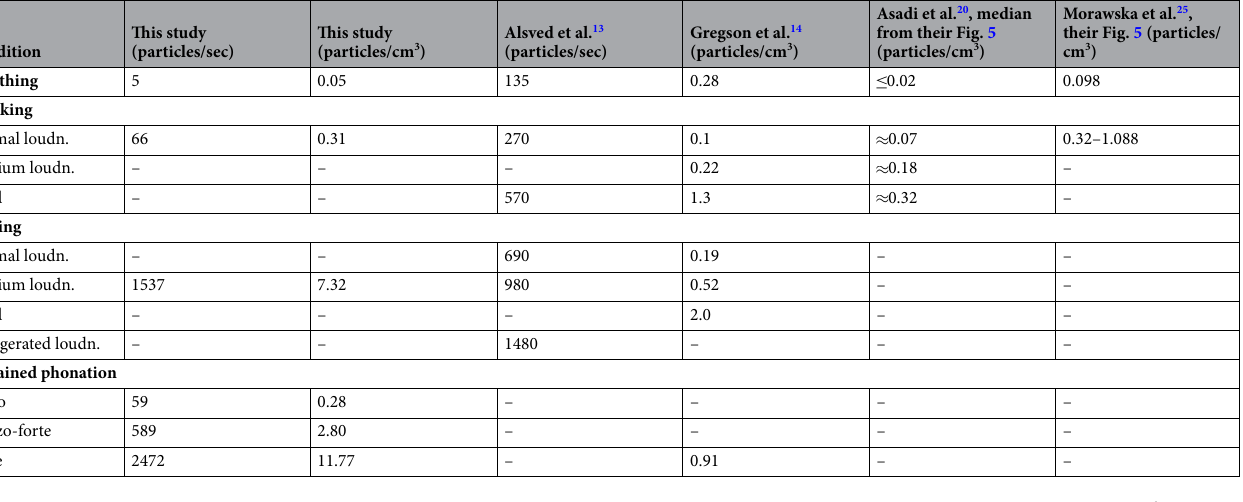
Table 4. Comparison of emission rates (in particles/sec) and particle concentrations (in particles/cm 3 ) determined in this study with previously reported data. The particle concentrations for our study were derived by dividing our emission rates with an airflow of 5.9 l/min for breathing and with an airflow of 12.6 l/min for all other conditions (see Salomoni et al. 31